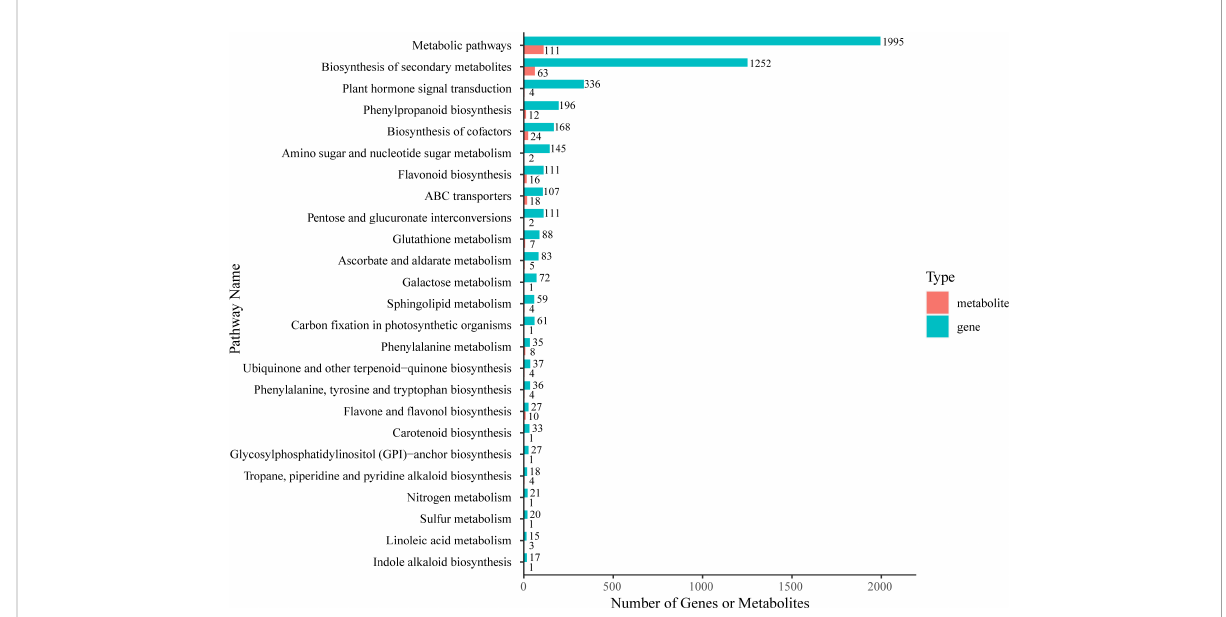
FIGURE 6 KEGG enrichment analysis of DEGs (green column) and DAMs (red column) that were enriched in the same